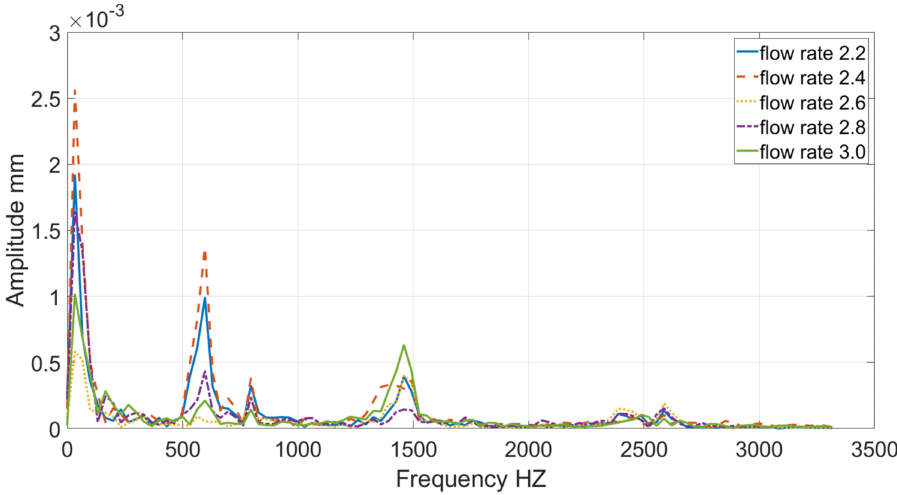
Figure 10. Relative displacement changing spectrum graph of sensor characteristic point under impacts of different momentum jets in the Y